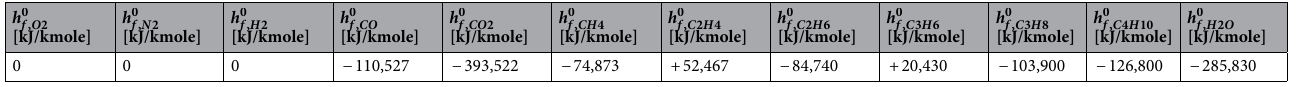
Table 6. The enthalpy of formation of chemical species in the flow sections “0”, “1”. p 0 = p 1 = 0.8 MPa, T 0 = T 1 = 298 K 38–44